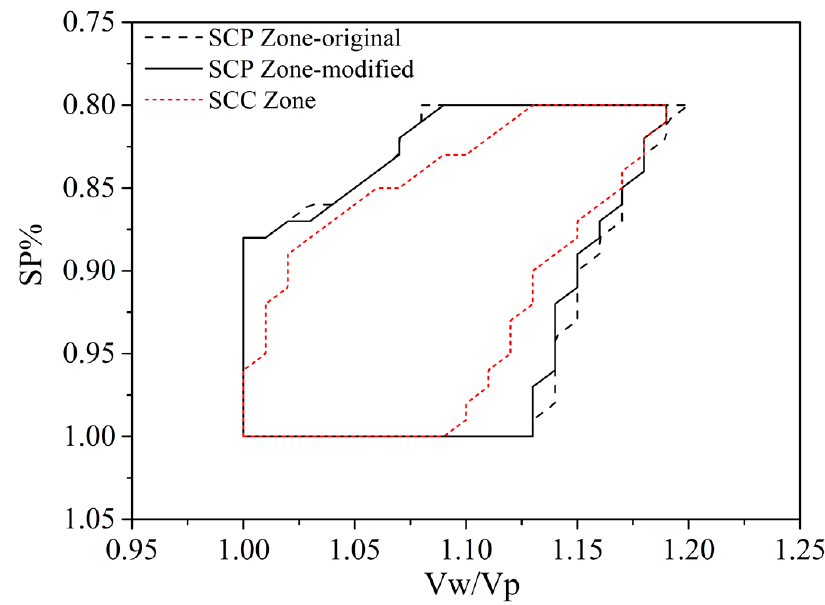
Figure 6. Self-compacting zones of series 2, cement substituted by 20% FA. In Figure 6, the original SCP zone is a little wider than the modified one, and their boundaries are similar. Additionally, they both contain the SCC zone, allowing the pos- sibility to obtain predictions with insufficient self-compacting performance. However, the boundaries of the modified SCP zone are slightly closer to the SCC zone, indicating a little more advancement in the prediction accuracy.